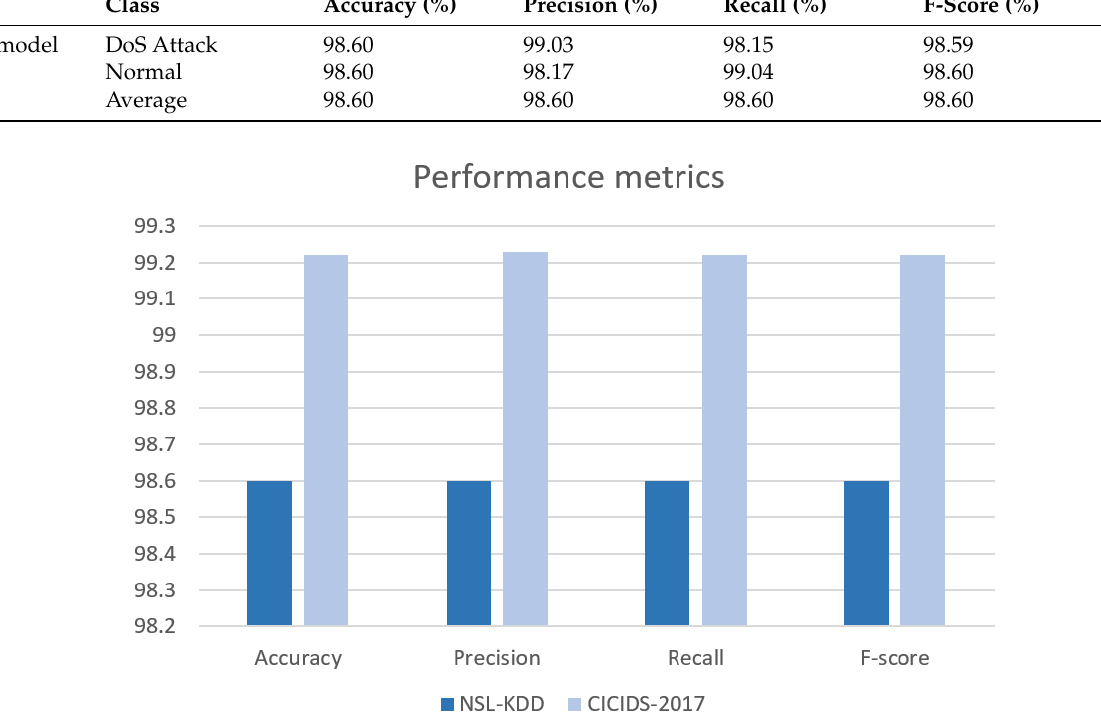
Figure 2. Comparison analysis of the developed RLSTM models using two datasets.